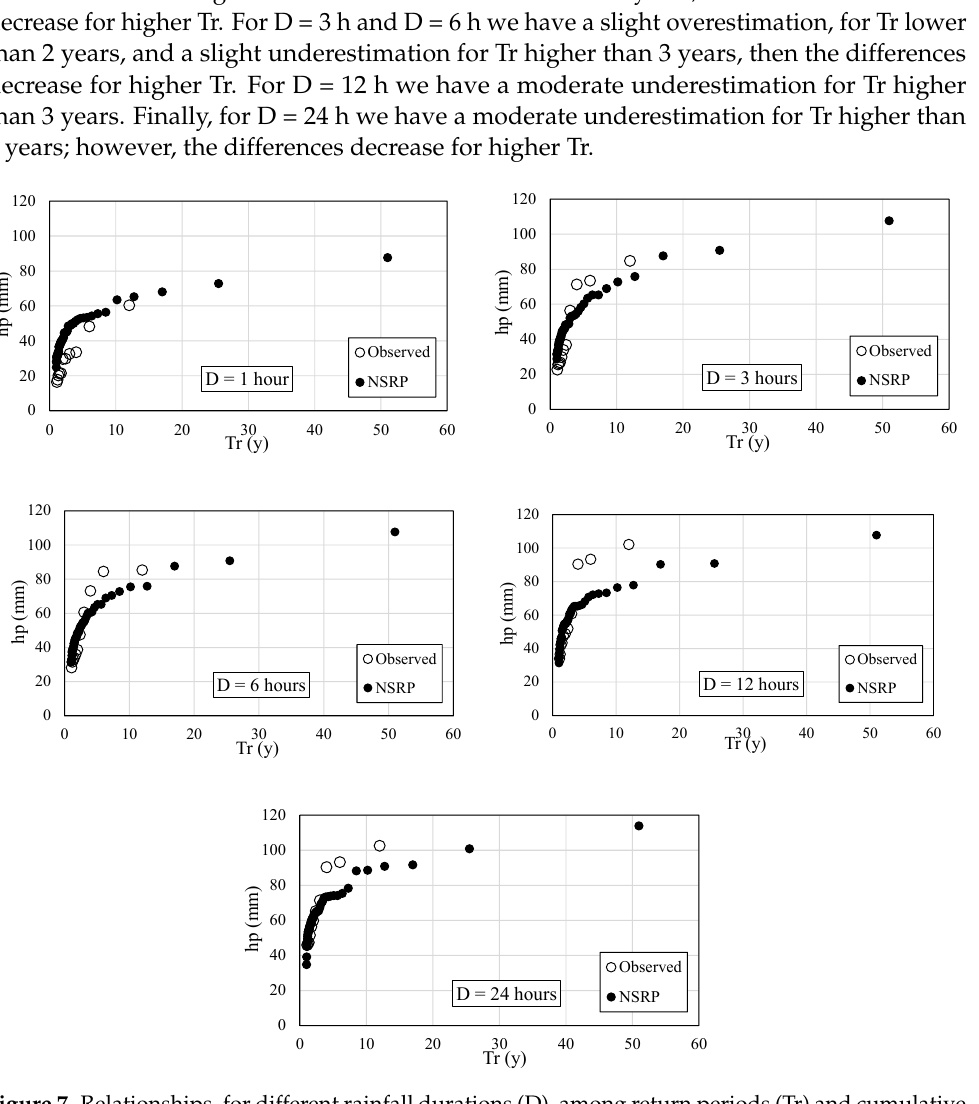
Figure 7. Relationships, for different rainfall durations (D), among return periods (Tr) and cumulative values of annual maxima rainfall (hp).